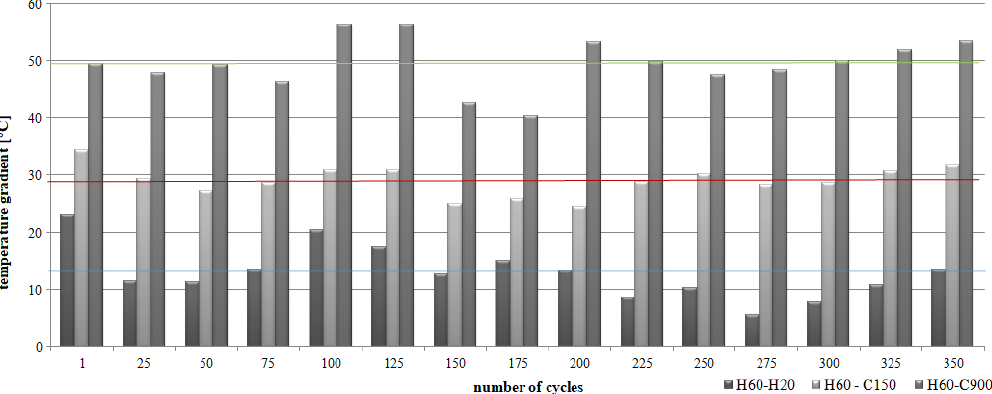
Figure 13. Gradient of the average temperature of the CC-1 concrete depending on the number of thermal cycles and the research period.